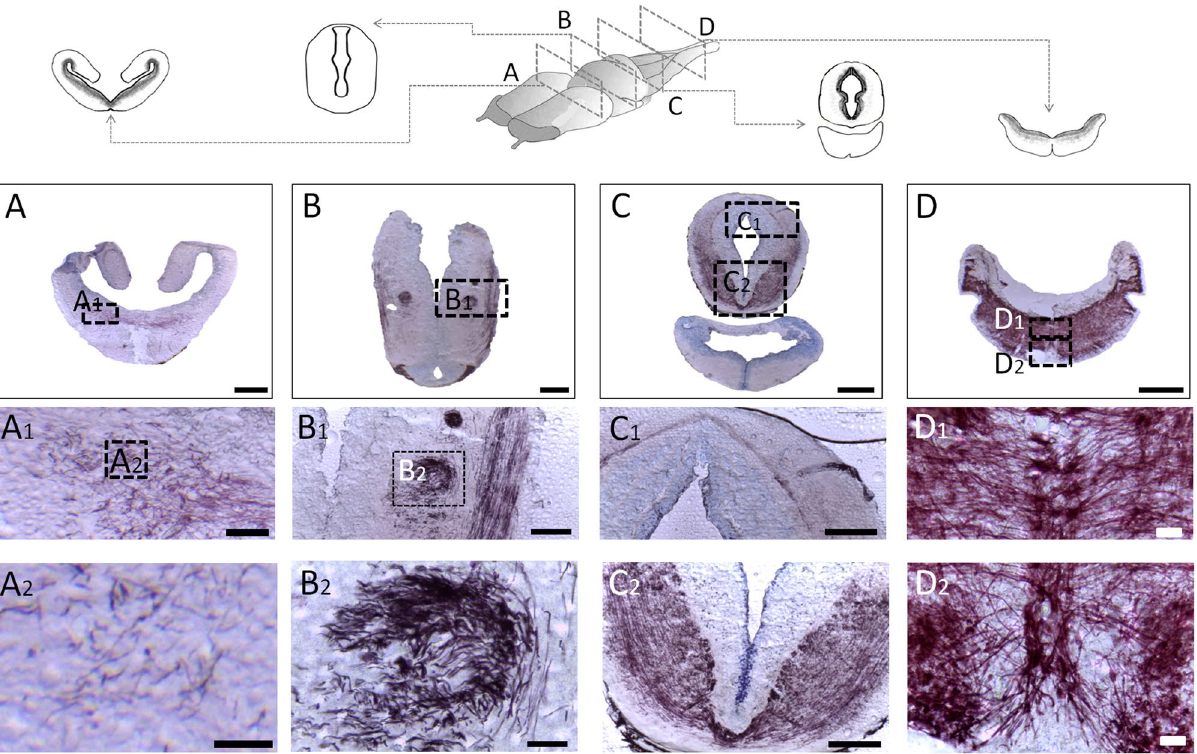
Figure 7. Myelination in the axolotl. Different coronal sections of the axolotl brain. ( A ) lateral/medial forebrain bundle/amygdaloid complex; ( B ) the dorsal thalamus; ( C ) the optic tectum/tegmentum, and ( D ) medulla oblongata. Below are amplifications for each section. Note the myelination gradient in the anteroposterior direction. The white matter of medulla oblongata is the structure with the greatest presence of myelin. The bars in the micrographs indicate 500 µm in ( A – D ), 100 µm in ( A1 , B1 , C1 , C2 ), and 20 µm in ( A2 , B2 , D1 , D2